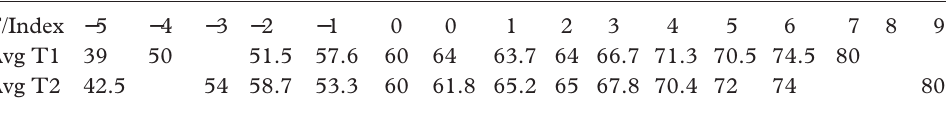
Table 3. Comparison of averages of non-compensated and compensated average